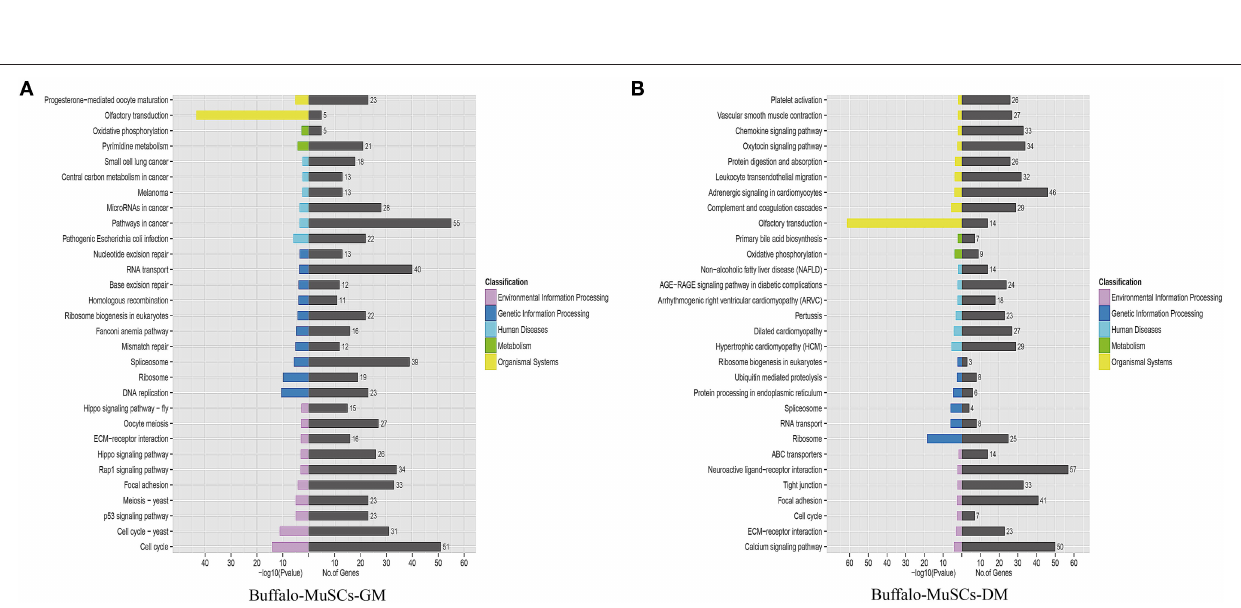
Figure 5C ), were selected for RT-qPCR verification. After comparisons with the RNA-seq data, similar expression trends for RT-qPCR were discovered, showing the strong consistency between RT-qPCR and RNA-seq